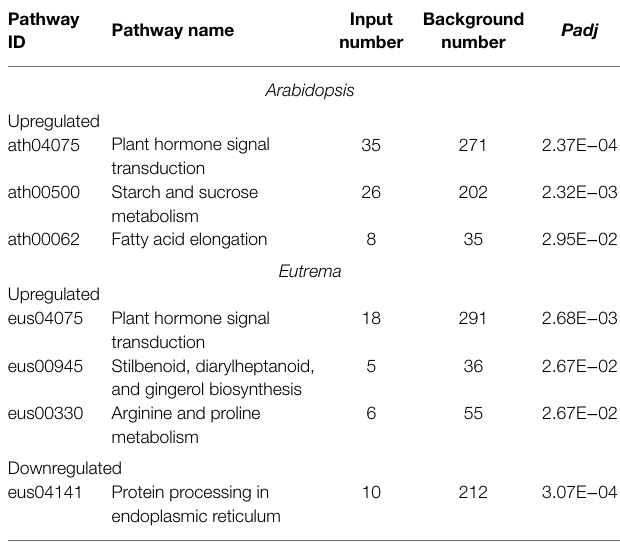
TABLE 1 | Kyoto Encyclopedia of Genes and Genomes (KEGG) pathway analysis of DE-PAC genes under salt stress in Arabidopsis and Eutrema